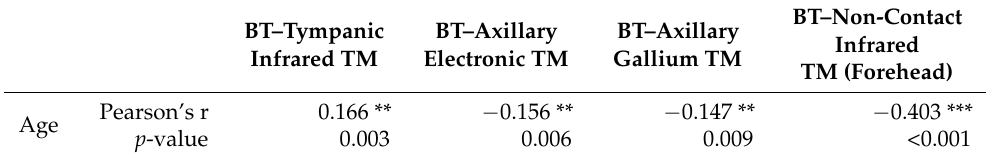
Table 4. Correlation of age and body